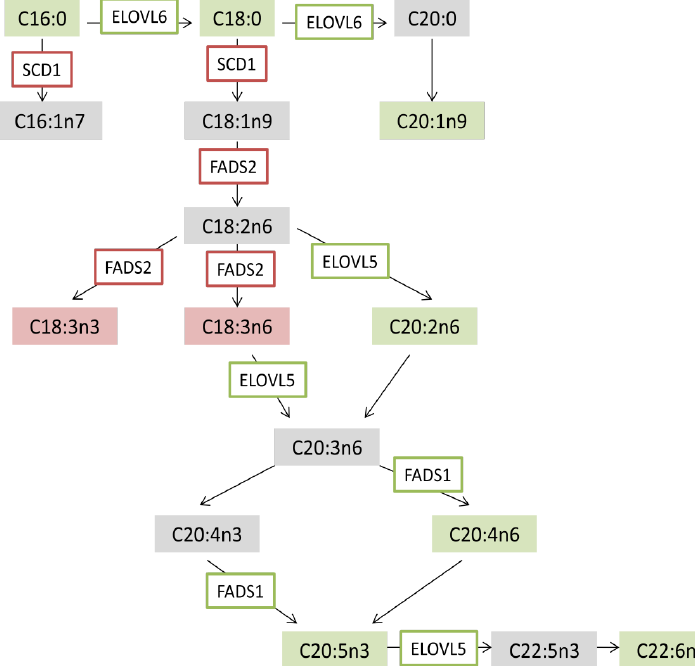
Figure 7. Fatty acid elongase and desaturase activities and lipogenic index in control cells, cells incubated with OA:PA (1.33:0.67 mM) and cells incubated with OA:PA treated with CeO 2 NPs (10 µ g / mL). C20:2n6 / C18:2n6c (ELOVL5) ( a ); C18:0 / C16:0 (ELOVL6) ( b ); C16:1 / C16:0 (SCD1-C16:0) ( c ); C18:1n9c / C18:0 (SCD1-C18:0) ( d ); C20:4n6 / C20:3n6 (FADS1) ( e ); C18:3n3 / C18:2n6c (FADS2) ( f ); C20:4n6 / C18:2n6c (ELOVL5 + FADS1 + FADS2 n-6 pathway) ( g ); C20:5n3 / C18:3n3 (ELOVL5 + FADS1 n-3 pathway) ( h ); C16:0 / C18:2n6c (lipogenic index) ( i ). * p < 0.05 compared with control; # p < 0.05 compared with OA:PA.